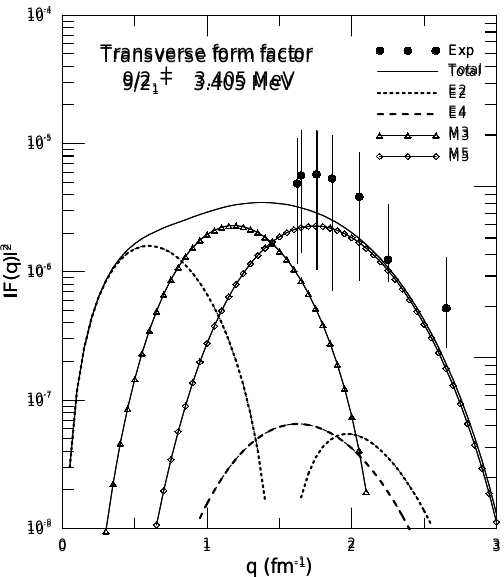
Fig. 4: Theoretical longitudinal and transverse form factors for 9/2 MeV using SkXcsb parameterization compared with experimental data